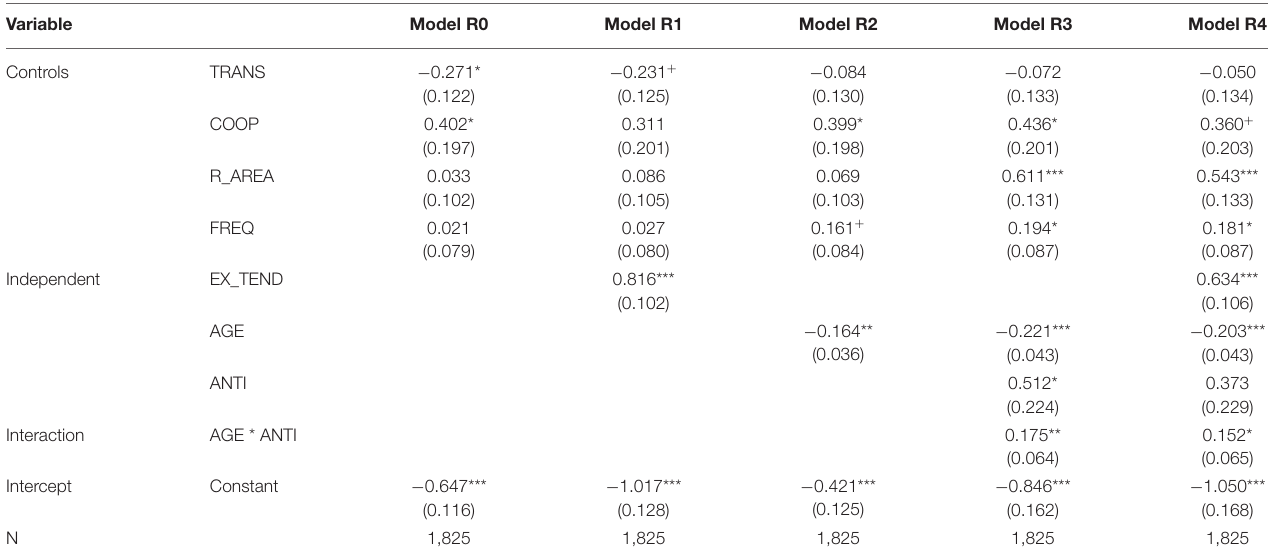
TABLE 5 | Robustness test